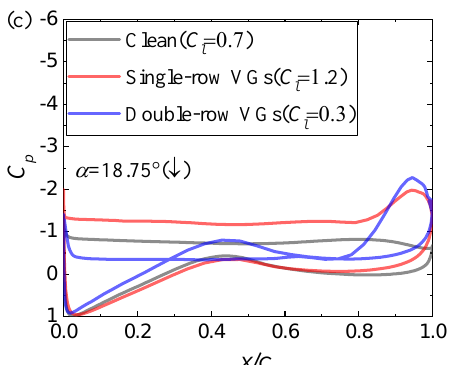
Figure 8. Pressure distributions of the airfoil with and without VGs. ( a ) α = 27.67° ( ↑ ); ( b ) α = 27.67° ( ↓ ); ( c ) α = 18.75° ( ↓ ).